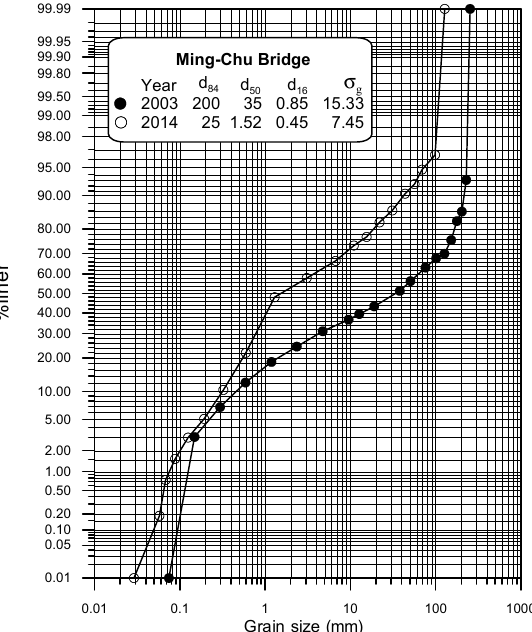
Figure 5. Size distribution of sediment particles around P4 of Mingchu Bridge.